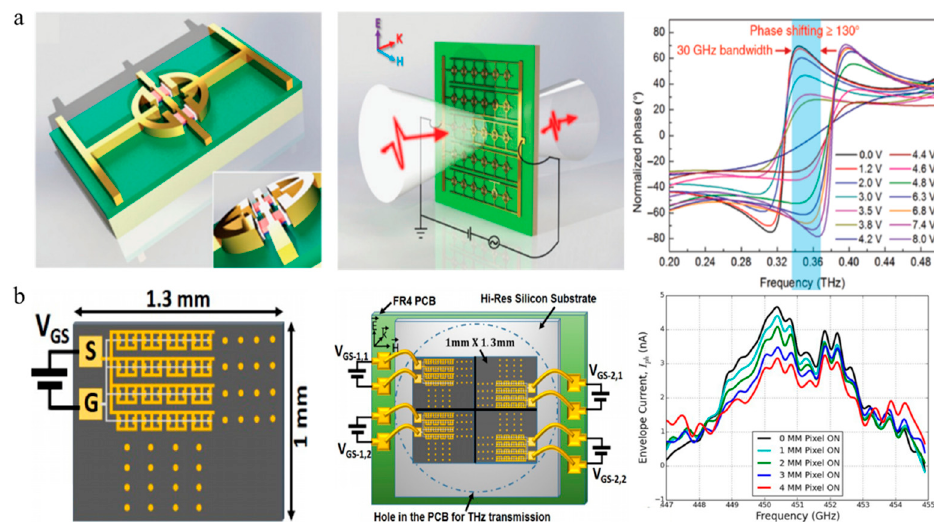
Figure 10. ( a ) Unit structure of THz phase modulator. Phase of incident THz wave can shift by applying different voltages. Reproduced with permission from [25]. ( b ) Structure of the terahertz wave-front modulator. Characterization when sequentially turning “on” each pixel of the spatial light modulator (SLM). Reproduced with permission from [83].